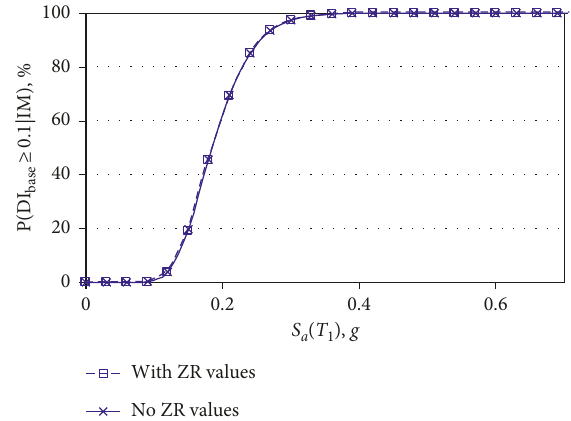
base in Figure 10: Fragility curve of DI base ≥ 0.1 in terms of S a ( T 1 ) with and without the effect of ZR